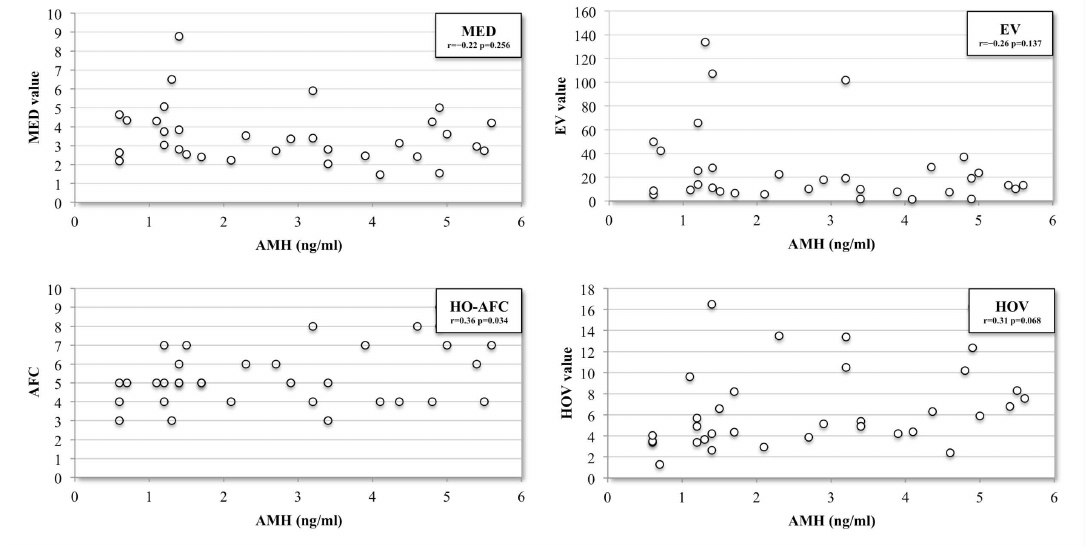
Figure 3. Scatterplots of the four absolute sonographic indicators. Pearson’s correlation coe ffi cient ( r ) testing the strength of the association between the independent variable (antimüllerian hormone (AMH) level) and the dependent variables (indicators), ranging from − 1 to + 1. EV: endometrioma volume;